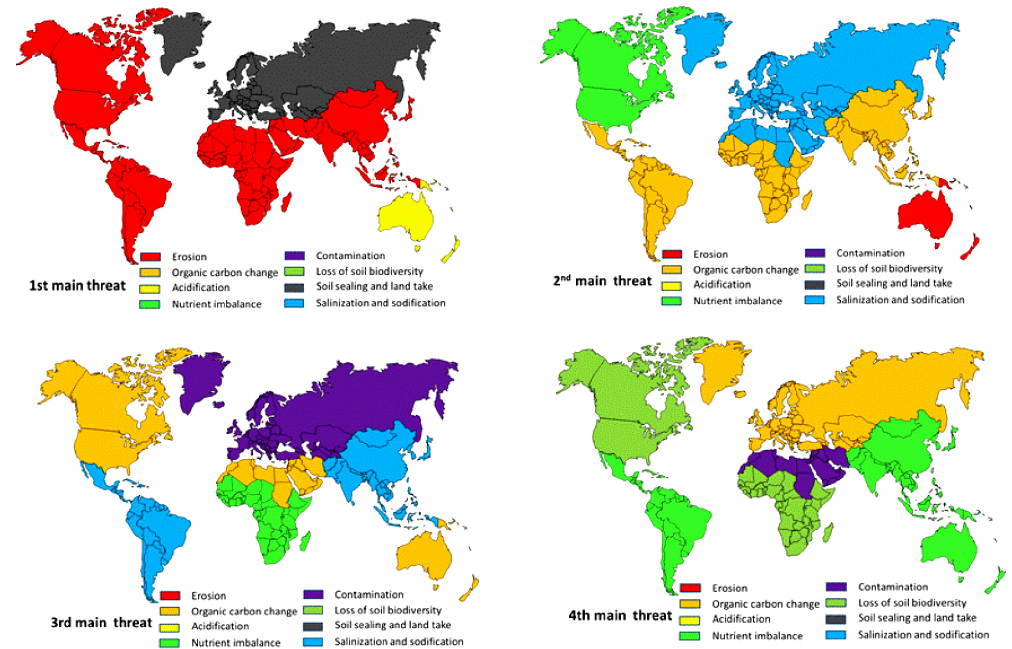
Figure 1. Global assessment of the four main threats to soil by FAO